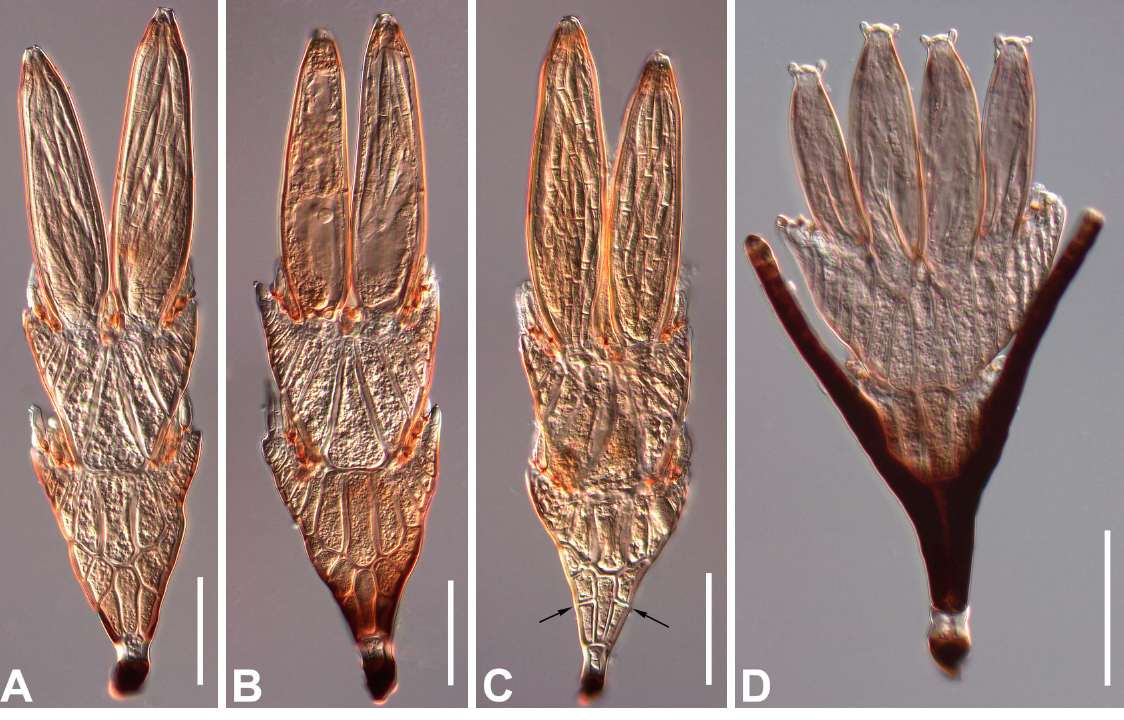
Fig. 69. Peyritschiella spp. A – C . P. princeps (Thaxt.) I.I.Tav. Mature thalli. In C arrows point to horizontal septa that divide the first two contiguous cells in the lower tier. – D . P. vulgata (Thaxt.) I.I.Tav. Mature thallus . Scale bars: 50 µm. Photographs from slides ZMUC C-F-122535 (A–B), ZMUC C-F-122536 (C), ZMUC C-F-123973